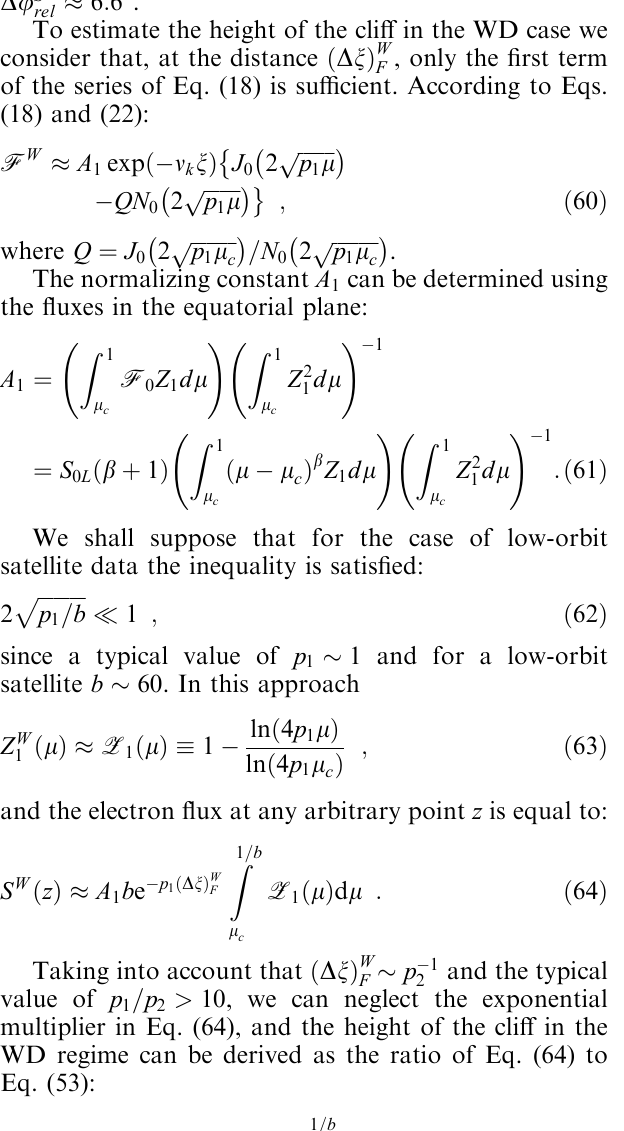
(cid:25) 2 B (cid:136) 0 : 3 s (cid:255) 1 (this corresponds to 1 2